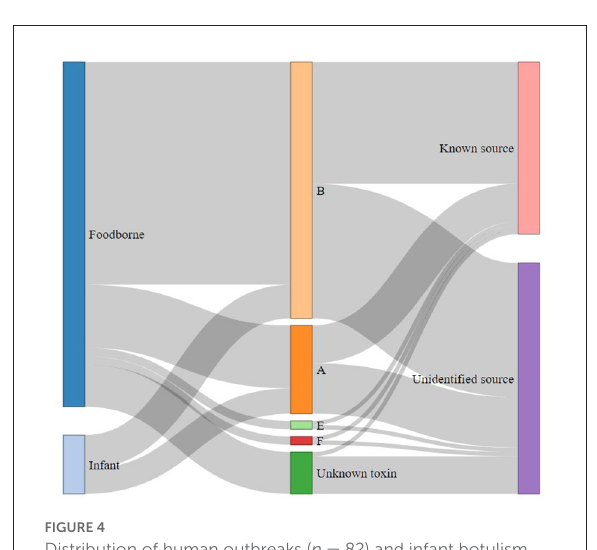
FIGURE4 Distribution of human outbreaks ( n = 82) and infant botulism outbreaks ( n = 14) according to botulinum toxin type and case origin identification over the period 2008–2018 in